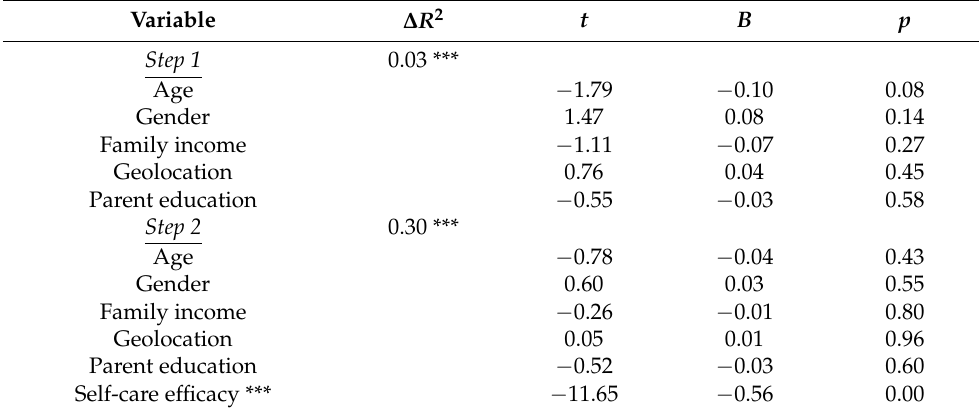
Table 3. Hierarchical regression estimates predicting negative emotions.